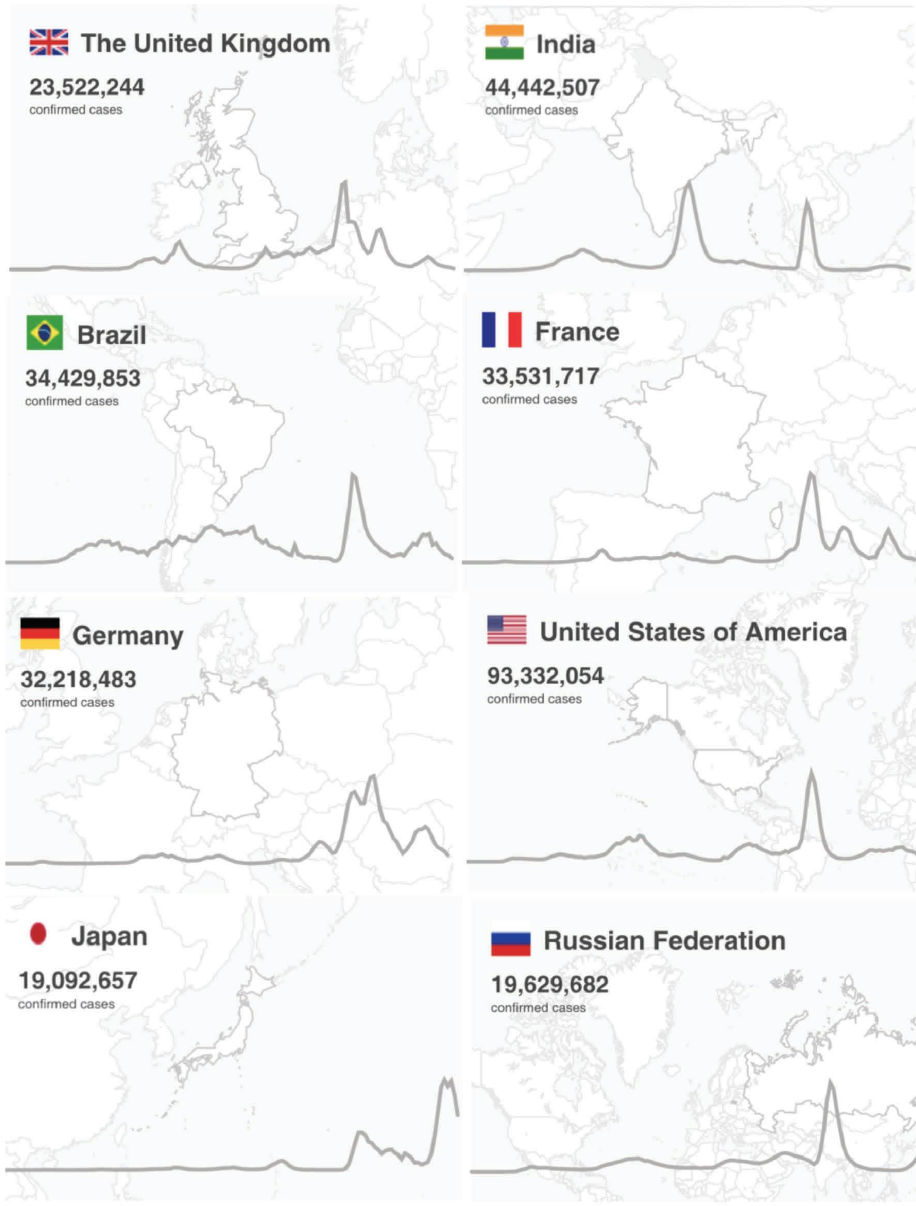
Figure 2: Current COVID-19 cases